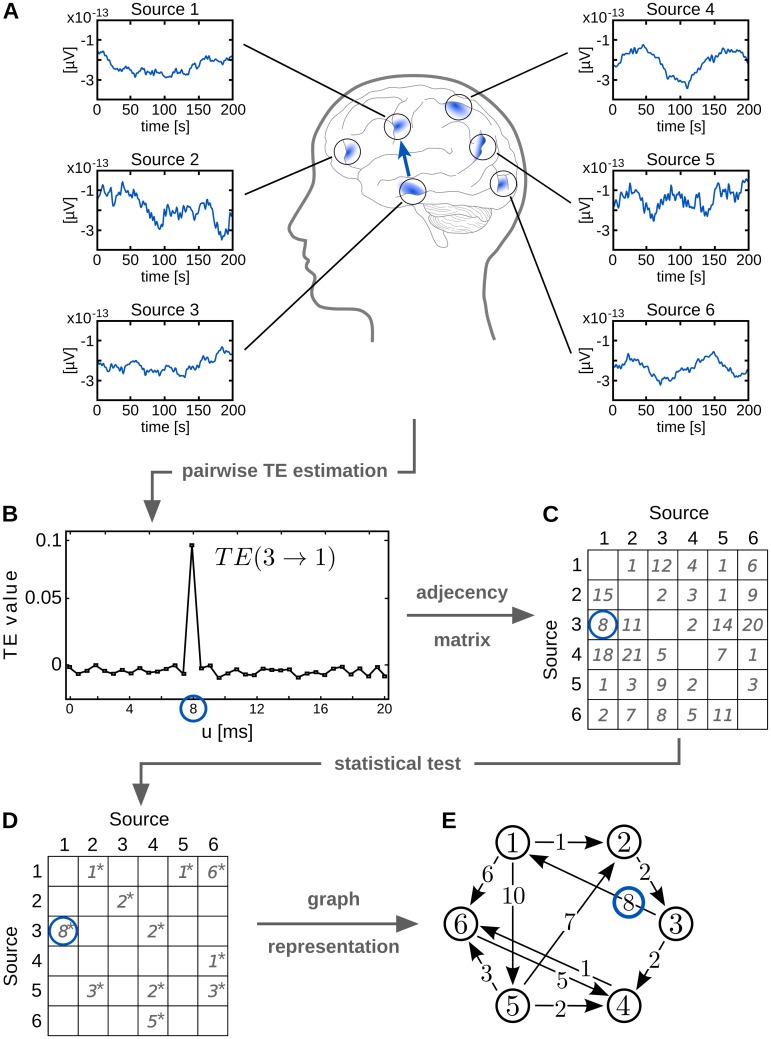
Graph representation of neural data.(A) Recorded signals from various sources in the brain; (B) Pairwise estimation of transfer entropy (TE) and reconstruction of interaction delays u between any two sources; (C) Adjacency matrix: representation of estimated delay times between all source combinations, every entry represents an information transfer from the ith row to the jth column; (D) Adjacency matrix after test for statistical significance; (E) Visualization of the graph represented by the connectivity matrix: every source is represented by a vertex, every significant information transfer is represented by an edge. (The blue circle indicates the respective representation of an exemplary interaction between source 1 and source 3 throughout all steps of graph reconstruction.)